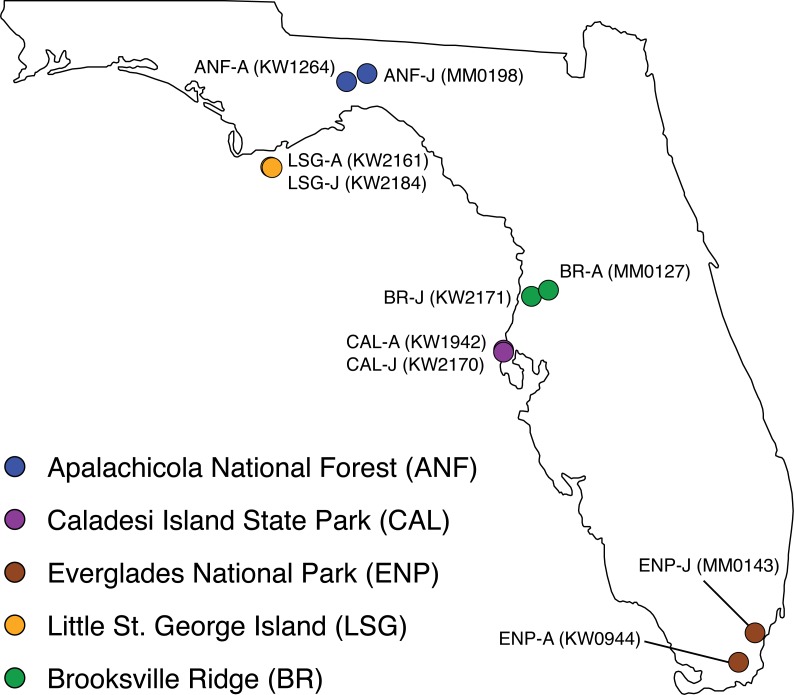
Collection localities of ten Crotalus adamanteus individuals used for venom-gland transcriptomics.Adult/juvenile pairs were collected from five regions previously shown (Margres et al., 2015a) to have different adult venom compositions. Abbreviations: A, adult; J, juvenile.